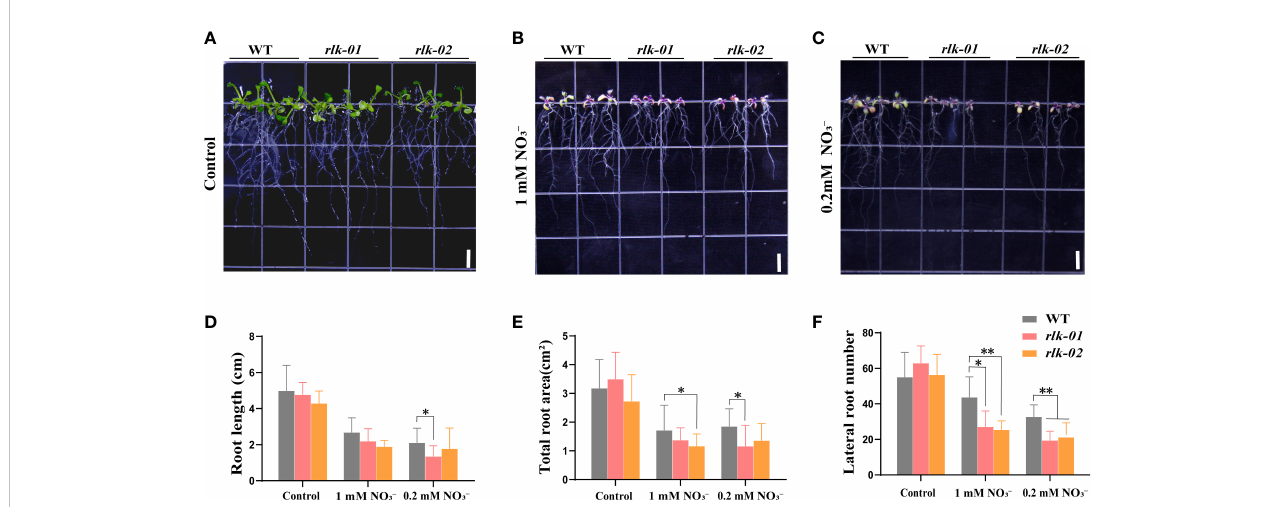
FIGURE 6 AtRLK plays a role in low nitrogen stress tolerance in Arabidopsis (A – C) Phenotypic analysis of mutant rlk and WT plants under control and nitrogen stress conditions. The rlk -01 and rlk -02 represent the same line plated out twice. (D) Root length, (E) total root surface, and (F) lateral root number in rlk mutant lines grown on 6 mM NO − 3 (control), 1 mM NO − 3 , and 0.2 mM NO − 3 media. All data represent mean ± standard deviation (n ≥ 6). Asterisks indicate signi fi cant differences compared to WT (* p< 0.05, ** p< 0.01, Duncan ’ s multiple range test). Scale bars = 0.5 cm.